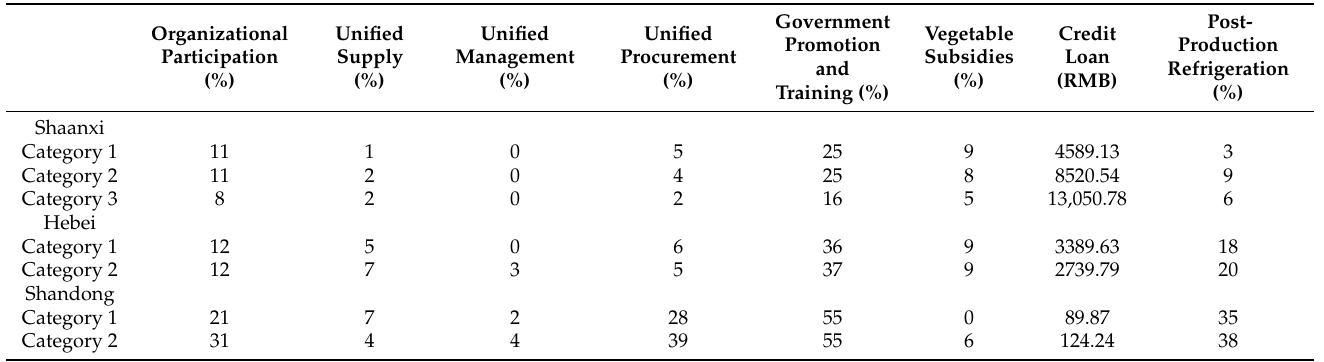
Table 4. Participation of tomato growers in productive